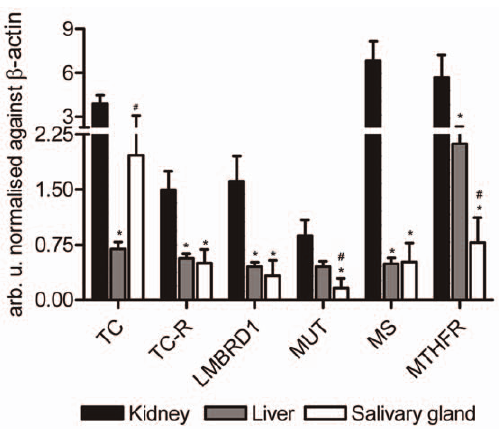
Figure 2. Transcript levels of selected genes involved in B12 metabolism in mice. The columns shown mean ( + SEM) mRNA levels determined by quantitative reverse–transcriptase (q–rt–) PCR and normalised against b –actin in kidney, liver, and salivary glands of control mice (n=7 mice of each tissue). Arb.u.: Arbitrary units. LMBRD1: lysosomal B12 transporter. MS: methionine synthase. MTHFR: methyle- netetrahydrofolate reductase. MUT: methylmalonylCoA mutase. TC: transcobalamin. TC–R: TC–receptor. Wilcoxon tests were carried out between kidney and liver or salivary glands (*p , 0.05) as well as between liver and salivary glands ( # p , 0.05).